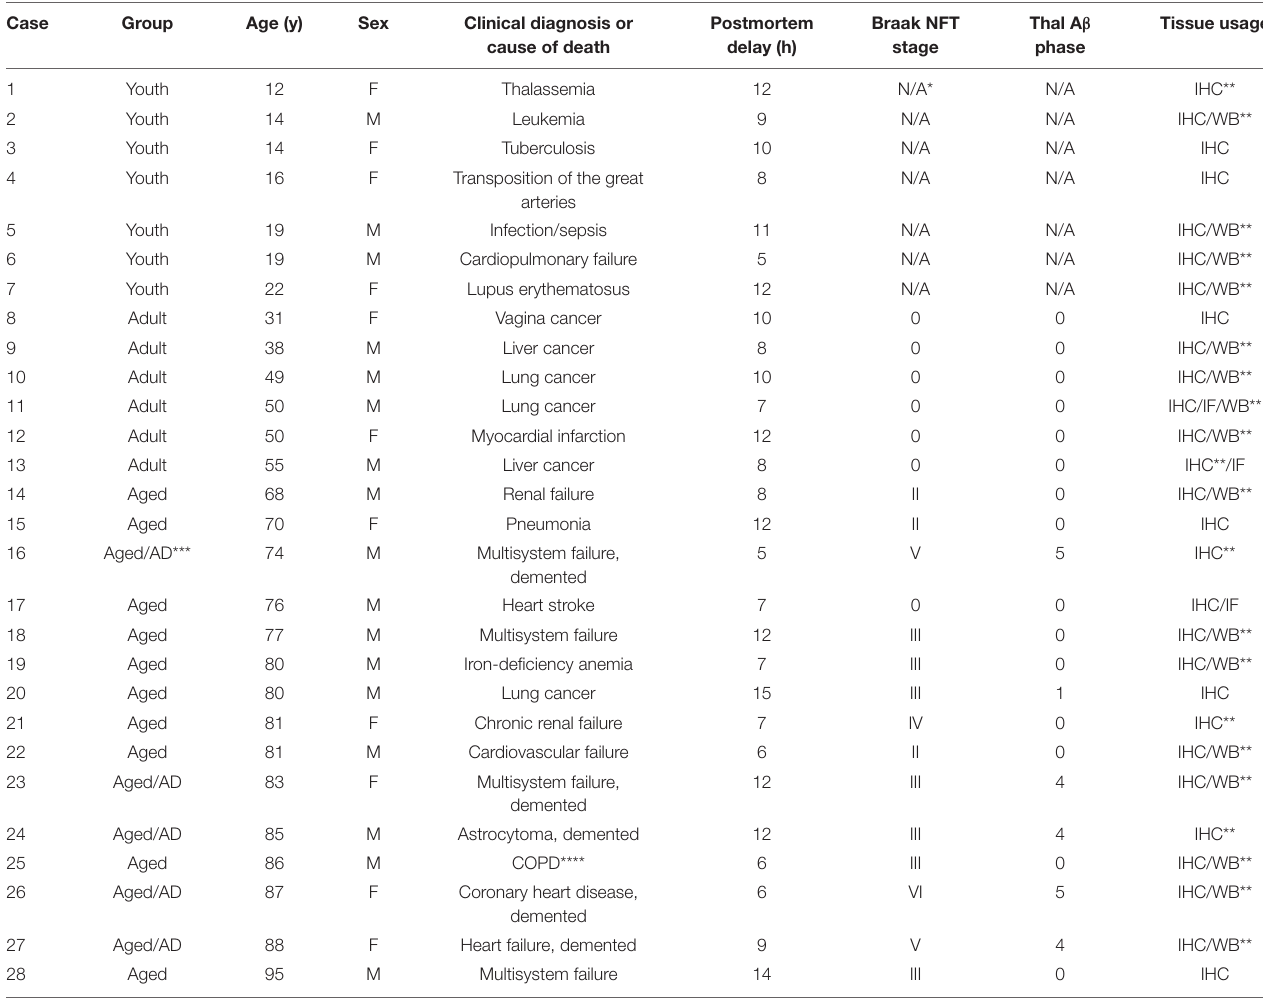
TABLE 1 | Demographic information of brain donors and staging of Alzheimer-type neuropathoplogy.